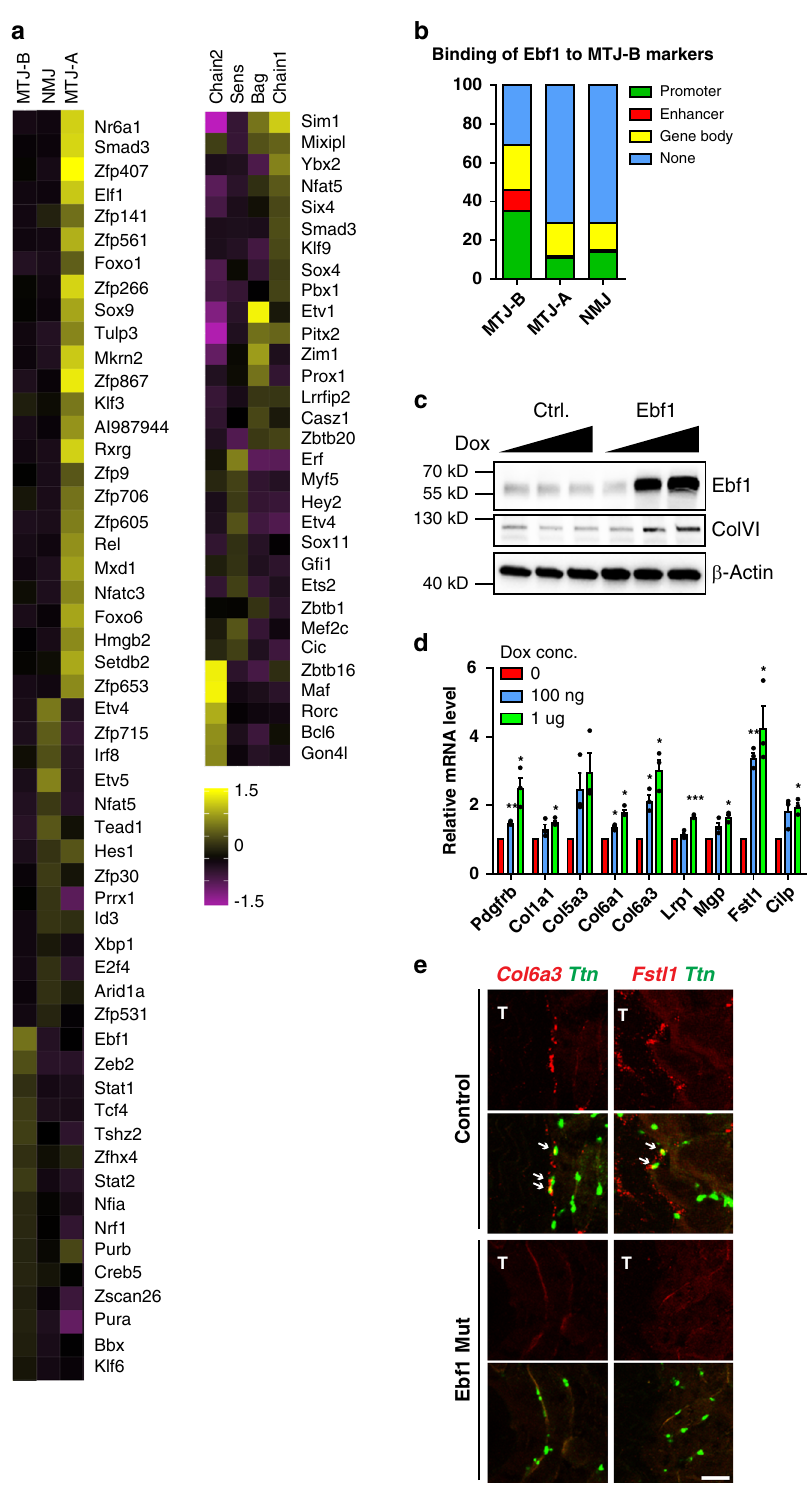
Fig. 6 Expression pro fi les of transcription factors and epigenetic regulators across distinct nuclear subtypes. a Heat-map showing the expression level of transcription factors and epigenetic regulators in indicated nuclear subtypes; see also Supplementary Data 4 for the full list including nuclear subtypes not shown in this fi gure. b Ebf1 directly binds to genomic regions of the top 100 genes identi fi ed to be speci fi cally expressed in MTJ-B nuclei (ENCODE project ENCSR000DZQ), but much less to markers of MTJ-A or NMJ. Classi fi cation of the Ebf1 binding sites in these 100 genes. c Western blot analysis of C2C12 cell line expressing doxycycline-inducible Ebf1. This experiment was repeated twice (two independent treatments), which showed the same results. d Indicated genes were analyzed by RT-qPCR before/after inducing Ebf1 expression. Error bars indicate S.E.M. Two tailed paired Student ’ s t test between untreated and Dox treated cells ( n = 3 independent treatments). *, p < 0.05. **, p < 0.01. ***, p < 0.001. The exact p -values are available in the source fi le. e Single-molecule FISH of indicated marker genes in TA muscle of control or Ebf1 mutant mice. Arrows indicate myonuclei expressing MTJ-B marker genes. T, tendon. Downregulation of expression was validated in four individuals. Scale bar, 50 µ